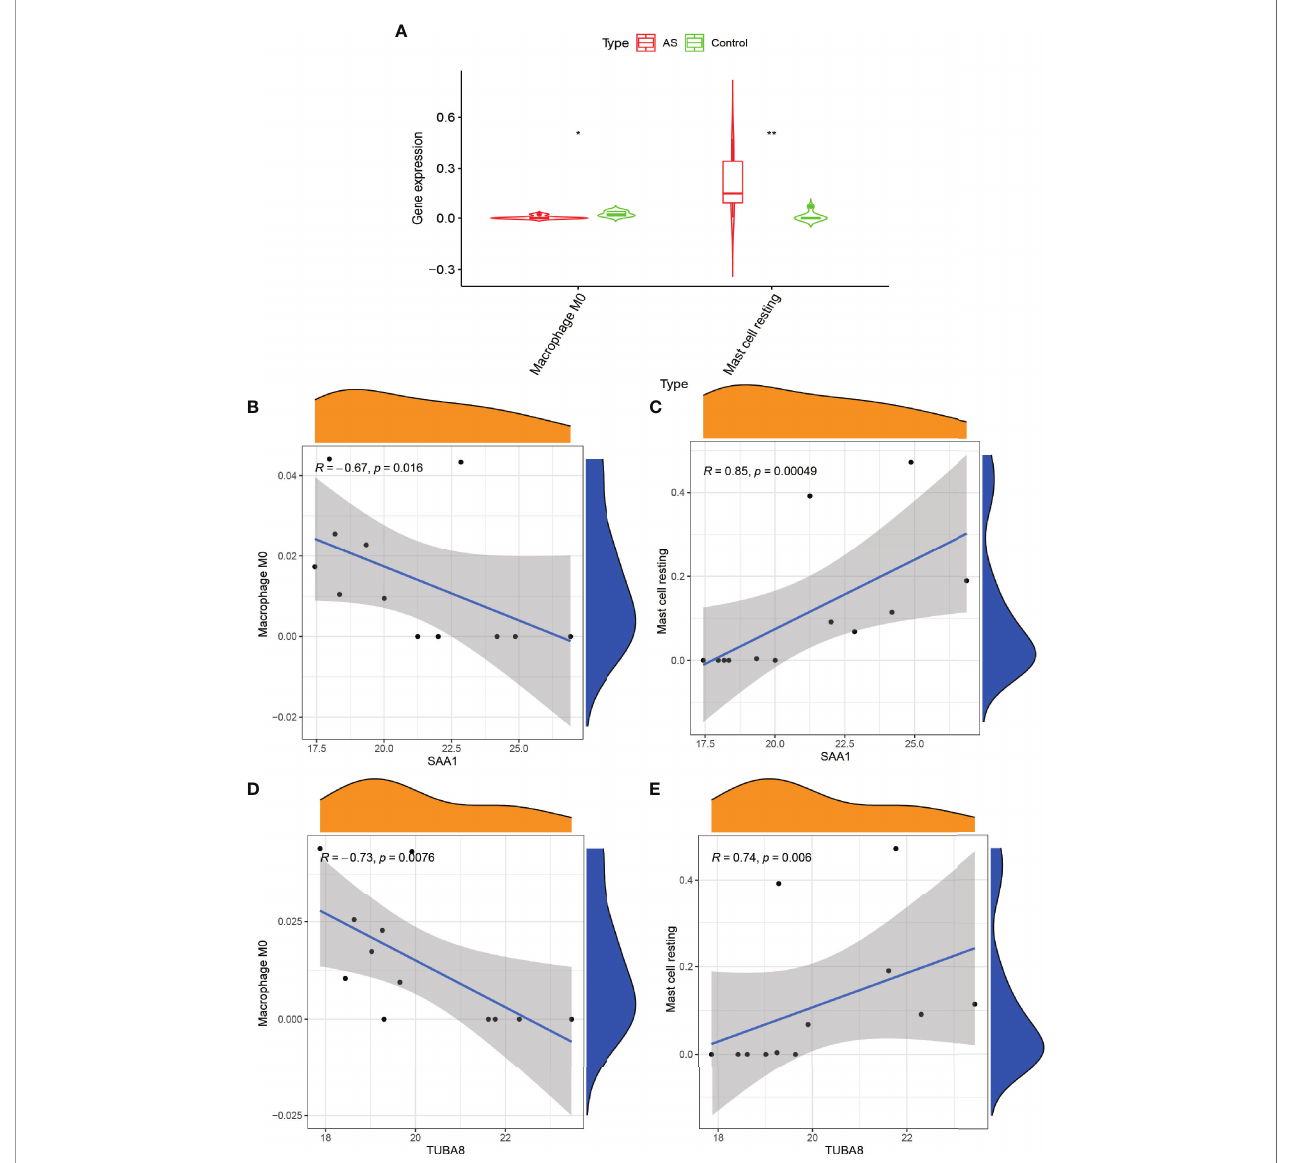
FIGURE 6 | Immune cell correlation analysis graph. (A) shows the immune cells obtained after analysis by CIBERSORT software at signi fi cant differences, “ * ” indicates P < 0.05, “ ** ” indicates P < 0.01. (B, C) represent the correlation analysis of gene expression of SAA1 with Macrophage M0 and Mast cell resting. Figure (D, E) represent the correlation analysis of gene expression of TUBA8 with Macrophage M0 and Mast cell